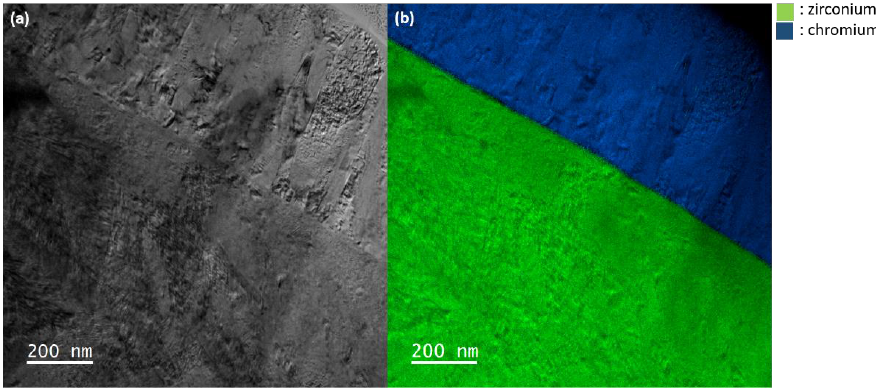
Figure 2. TEM images of the Cr-coated zircaloy-4: ( a ) bright-field TEM showing both the Zr and Cr regions, ( b ) energy-filtered jump ratio images obtained at the Zr M and Cr M edges.